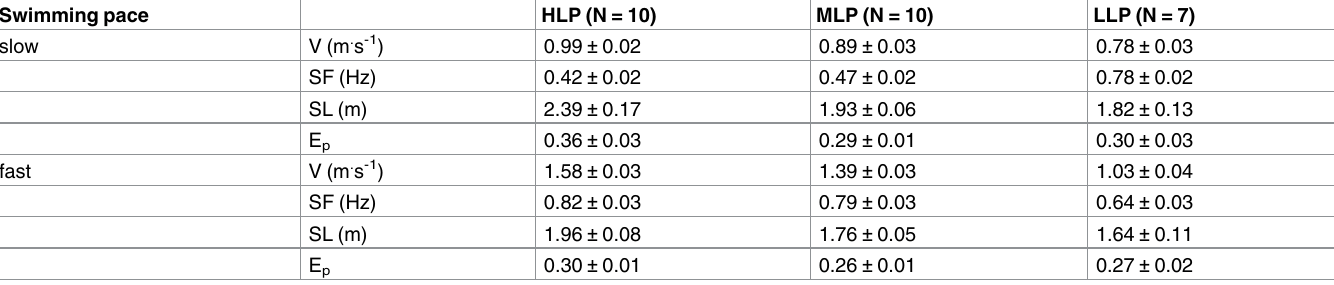
Table 3. Kinematic data at slow and fast swimming pace (data are means ± SE). Swimming